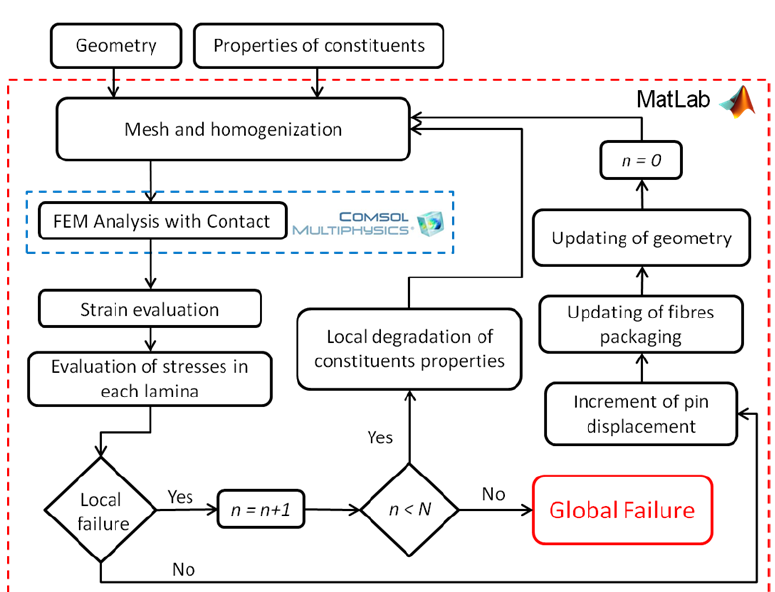
Figure 3: Flowchart of the incremental numerical procedure implemented in this study.